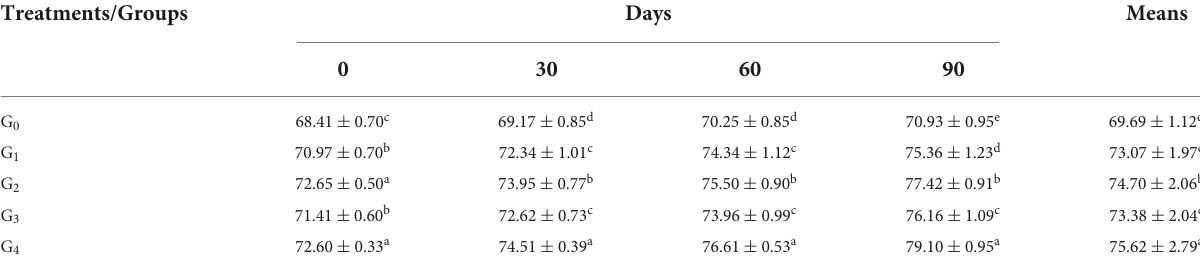
Means carrying the same letters in a column are not significantly different. G 0 = Control Group (no prebiotic given), G 1 = 963 mg/kg Inulin + 10 ppm NaFeEDTA, G 2 = 963 mg/kg Inulin+20ppmNaFeEDTA,G 3 =963mg/kgGOS+15ppmFeSO 4 ,G 4 =963mg/kgGOS+30ppmFeSO 4 .